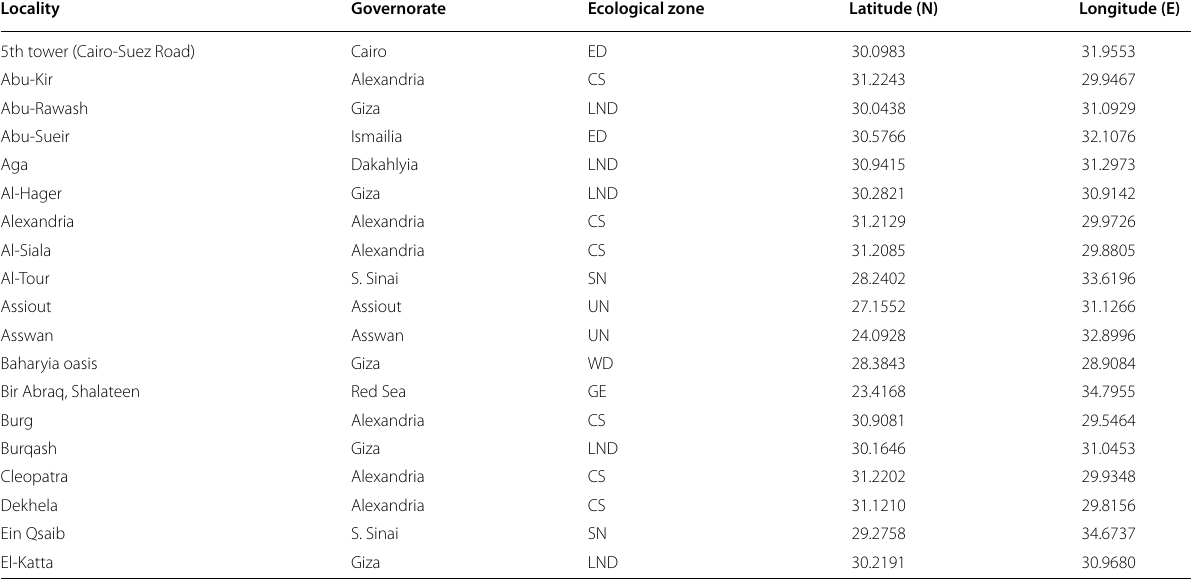
Table 2 A gazetteer of dolichopodid localities in Egypt